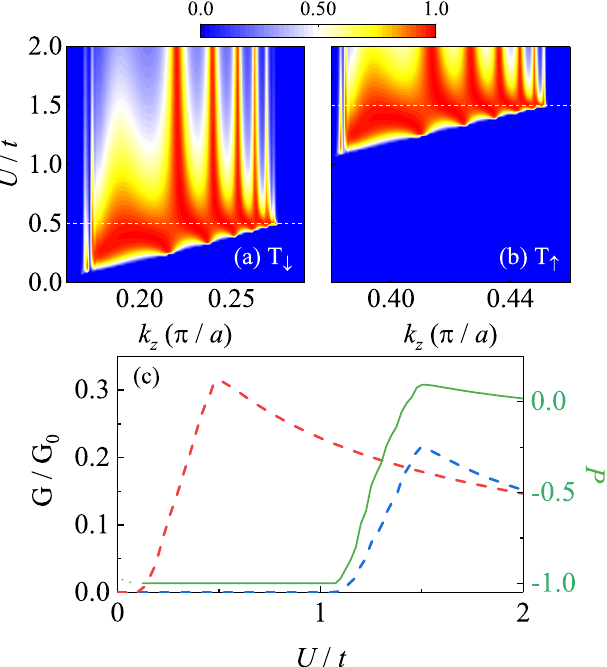
Figure 3. The dependence of Transmission coefficients on both U and k z of the ( a ) spin-down and ( b ) spin-up subband near the corresponding Weyl nodes. ( c ) The spin-dependent conductance (red and blue dashed lines) and the spin polarization (green line) via the barrier U . We choose B (cid:31) = 0.5 k 2 cz and B 0 = 0 . Other parameters are the same as those in Fig.